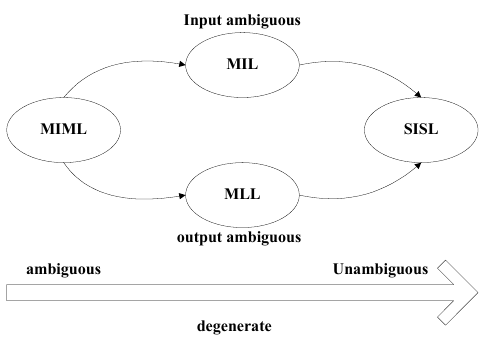
Figure 1. The relationship among these four learning